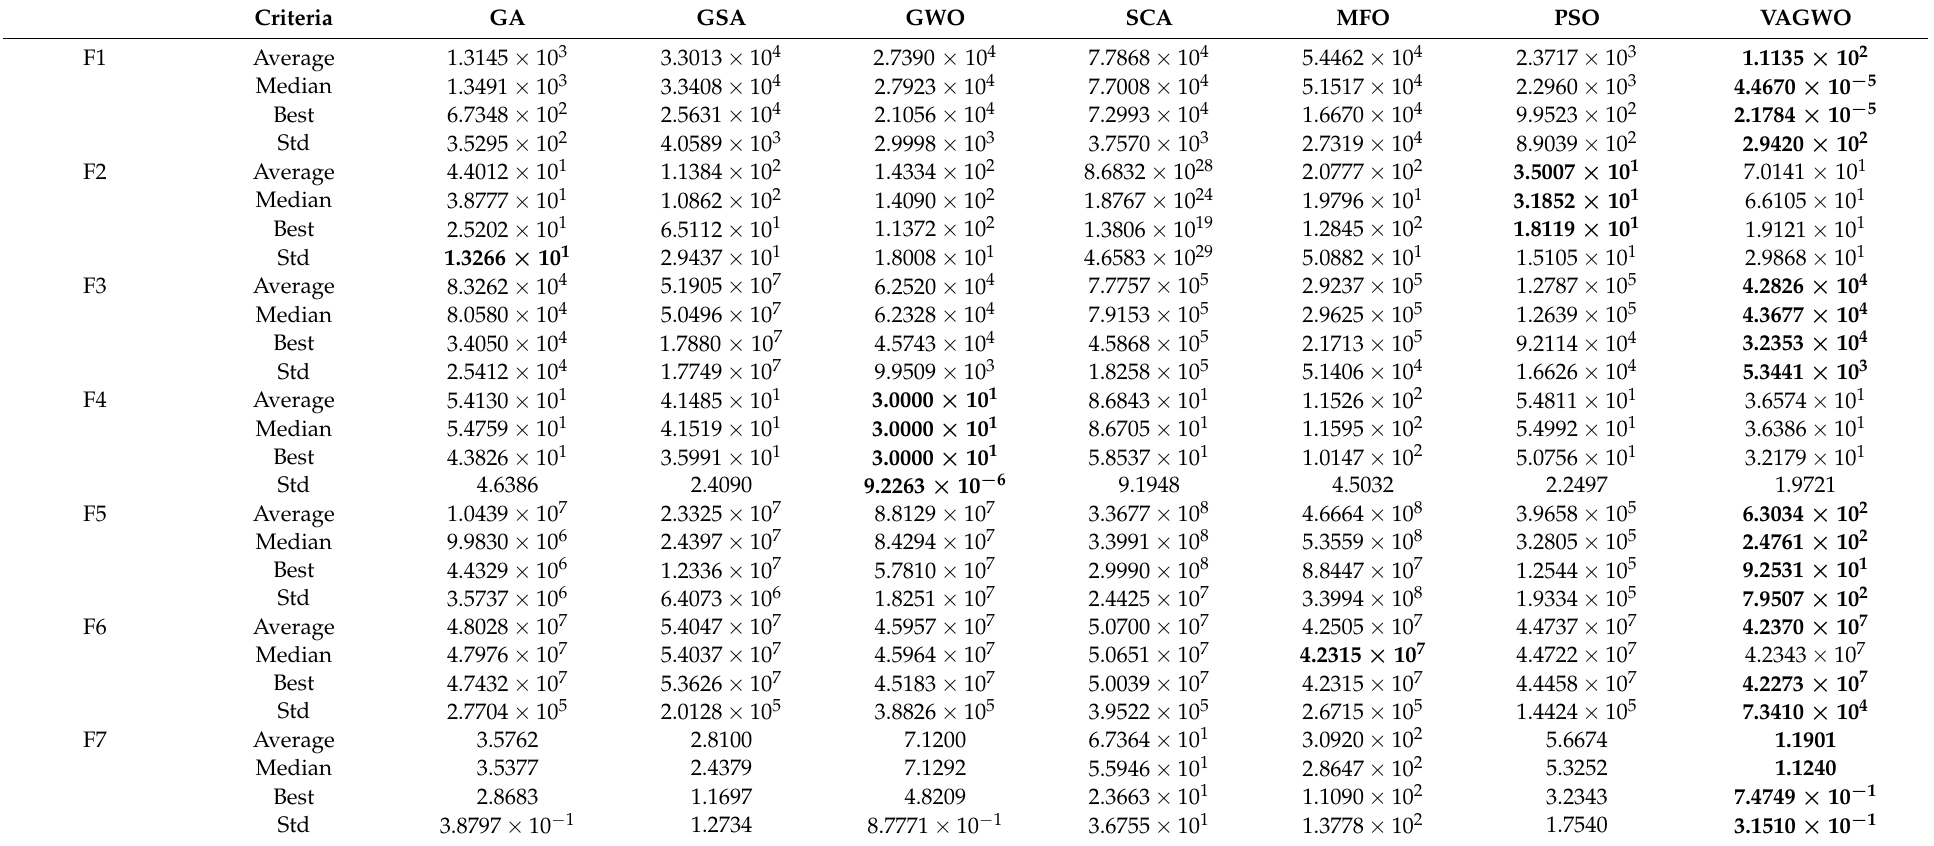
Table 2. The results achieved by the VAGWO against the popular algorithms for the uni-modal functions at D = 100.